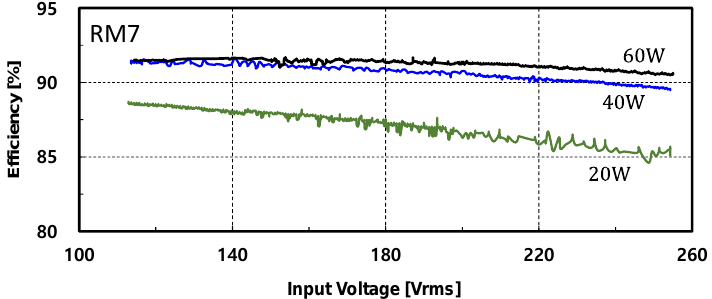
Figure 25. Power conversion efficiency characteristics versus input voltage of a QR flyback converter with SDAS at 20 W, 40 W, and 60 W power load.